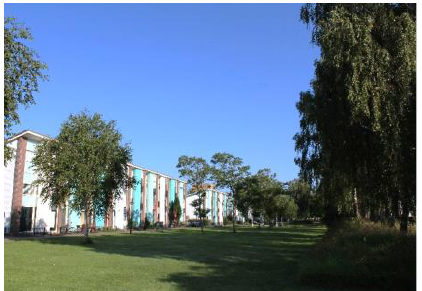
Figure 4. The three green spaces on which our project focuses (Google Maps).